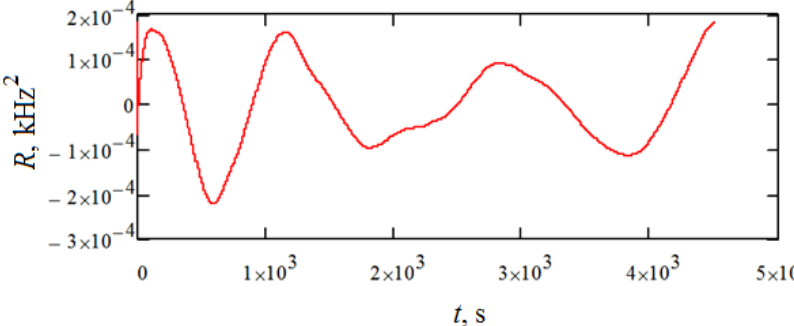
Figure 8. Correlation function.